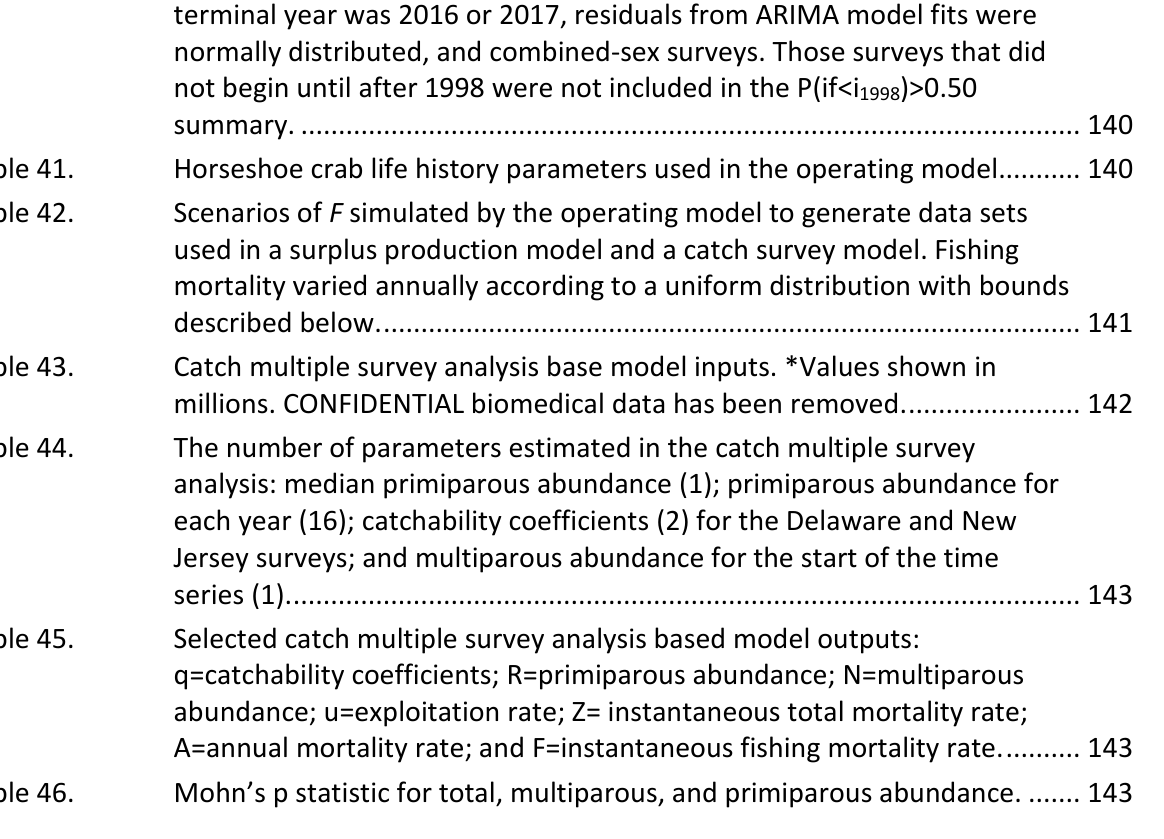
were calculated as the probability of detecting a 50% change following the methods of Gerrodette (1987). Sex includes all mature horseshoe crab or multiparous (M) or primiparous (P) if indicated. ............................... 135 List of surveys used in the regional Conn indices and their associated sigma values, or the standard deviation of the process error. All surveys are for combined sexes and adult horseshoe crabs unless specified in the Results of autoregressive integrated moving average (ARIMA) model fits for horseshoe crab surveys. W is the Shapiro-Wilk test statistic for normality of residuals (p value in parentheses); n is the number of years in the time series; r1, r2, and r3 are the first three autocorrelations; θ is the moving average parameter; SE is the standard error of θ; and σ 2 c is the variance of the index. ............................................................................... 137 Reference points from the ARIMA model for each survey and the probability that the terminal year's fitted index (i f ) is below the reference point. The 1998 reference is i 1998 and the lower quartile reference is Q 25 . Reference points are based on ln transformed index values. Surveys that Number of surveys with terminal year having a greater than 0.50 probability of being less than the reference point (i.e. likely less than the reference point). Time series were only included in this summary if the terminal year was 2016 or 2017, residuals from ARIMA model fits were normally distributed, and combined-sex surveys. Those surveys that did not begin until after 1998 were not included in the P(if<i 1998 )>0.50